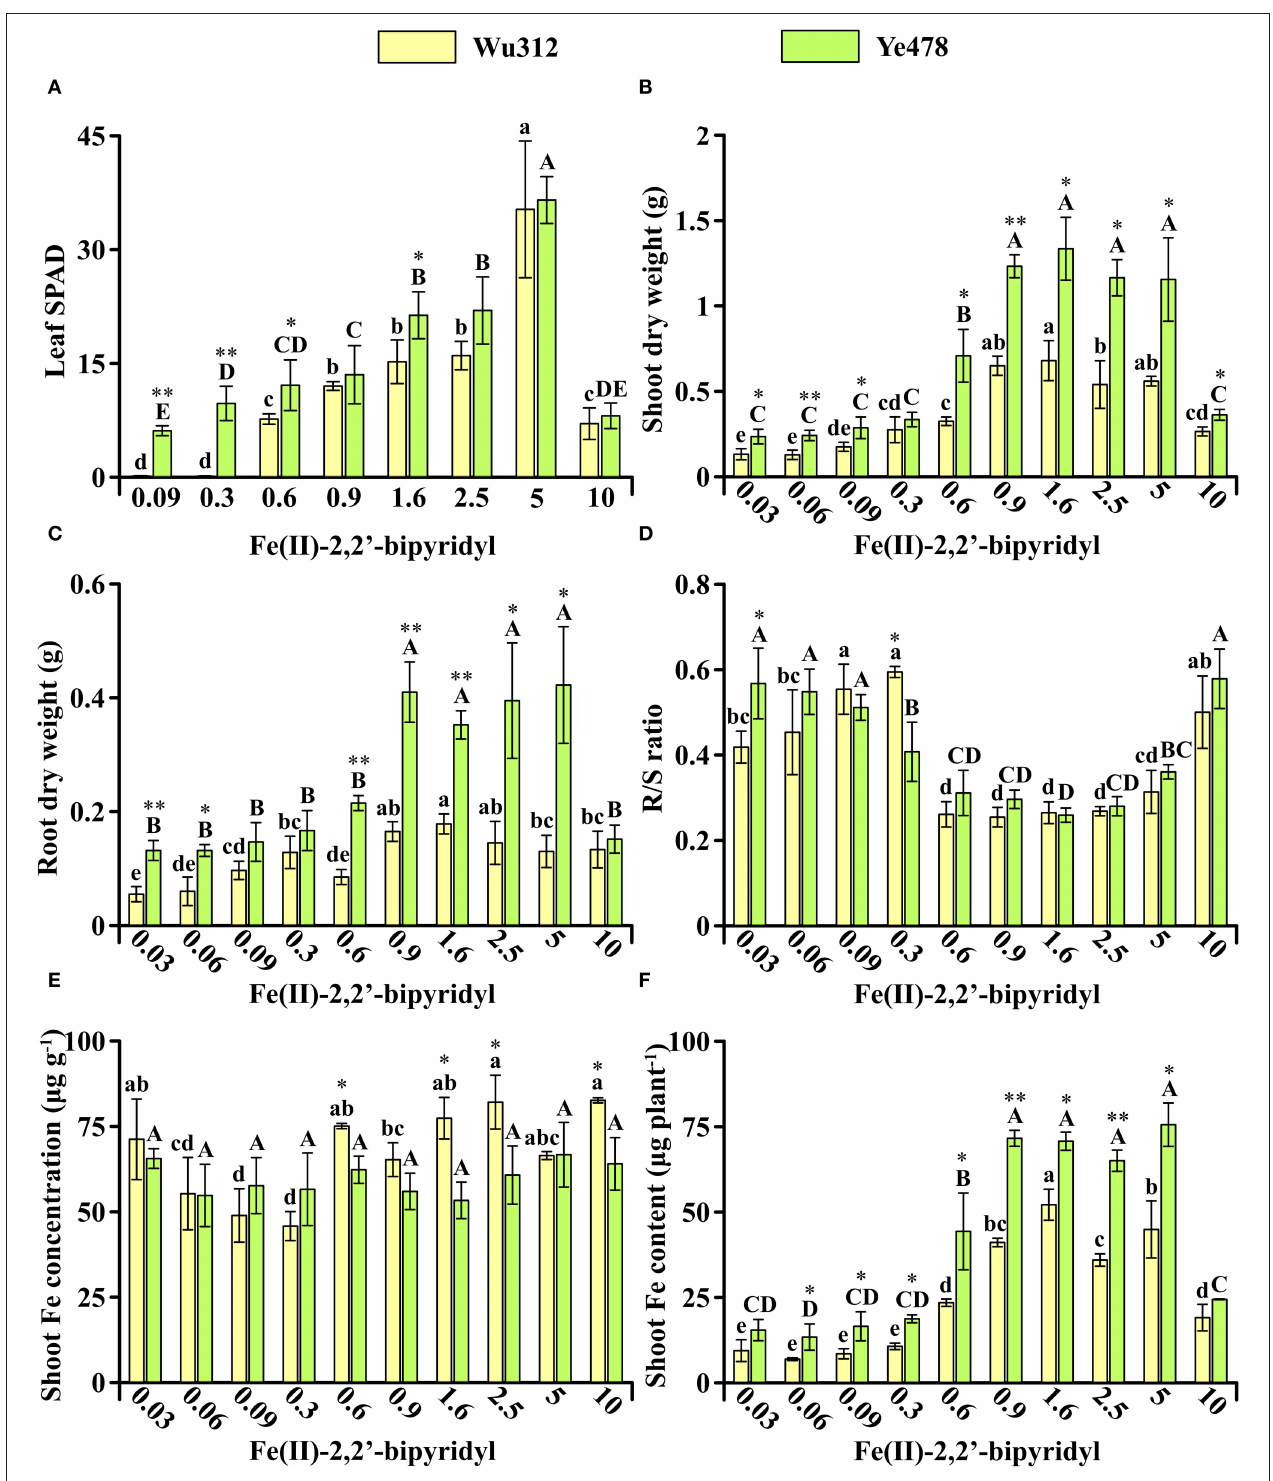
FIGURE 2 | Effects of different Fe supply levels on plant growth of Wu312 and Ye478 during the same period in Experiment 1. (A) Leaf SPAD; (B) shoot dry weight; (C) root dry weight; (D) R/S ratio; (E) shoot Fe concentration; (F) shoot Fe content. Different lowercase (uppercase) letters indicate significant differences in Wu312 (Ye478) among different treatments at P < 0.05. * and ** indicate significant differences between Wu312 and Ye478 in the same treatment at P < 0.05 and P < 0.01, respectively.